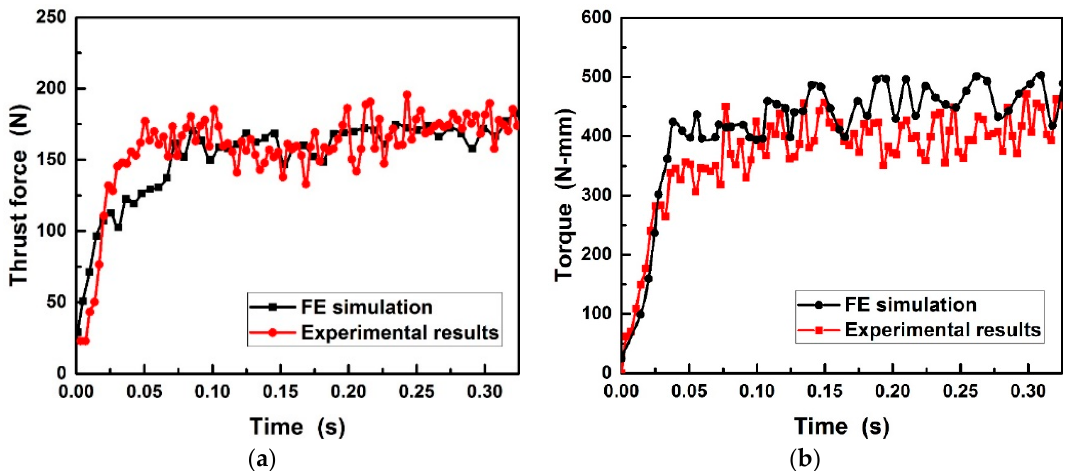
Figure 10. Comparison of ( a ) thrust force and ( b ) torque between FE simulation and experiment during drilling Al6063/SiC p /65p composites using brazed PCD drill.